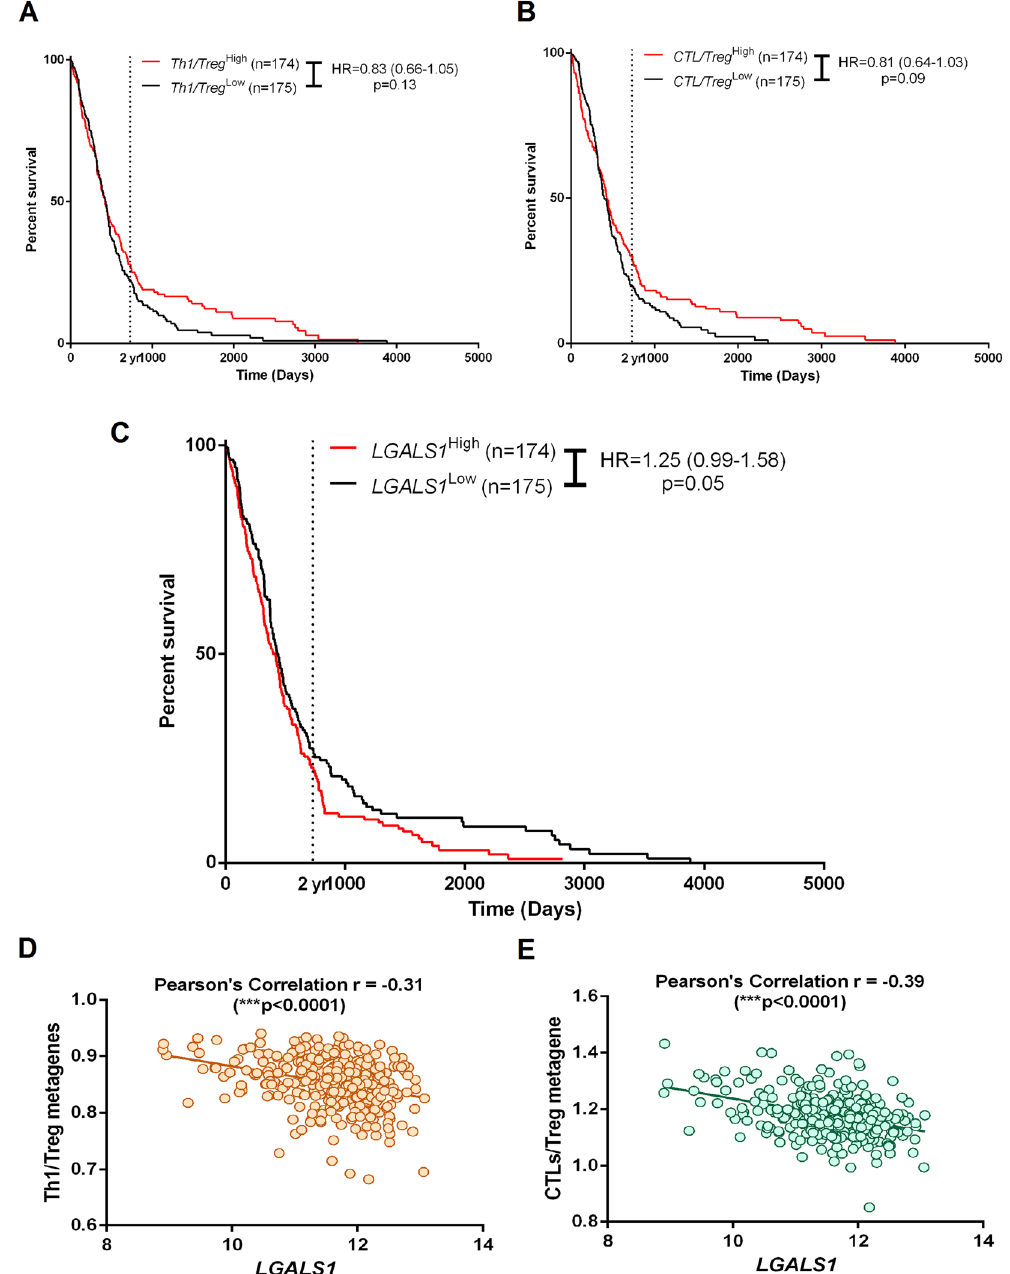
Figure 5. Analysis of association between T cell-associated genetic signatures and LGALS1 in human glioblastoma (GBM) patients. ( A ) The ratio of genetic signatures or metagenes specific for Th1 and Treg was used to stratify the The Cancer Genome Atlas (TCGA) GBM patients into “high Th1/Treg ratio” (red) or “low Th1/Treg ratio” groups; followed by Kaplan-Meier plotting of patient’s overall survival versus follow-up duration in days. ( B ) The ratio of genetic signatures or metagenes specific for CTLs and Treg was used to stratify the TCGA GBM patients into “high CTL/Treg ratio” (red) or “low CTL/Treg ratio” groups; followed by Kaplan- Meier plotting of patient’s overall survival versus follow-up duration in days. ( C ) The differential expression of LGALS1 was used to stratify the TCGA GBM patients into “high expression” (red) or “low expression” groups; followed by Kaplan-Meier plotting of patient’s overall survival versus follow-up duration in days. In A–C graphs, log-rank (Mantel-Cox) test p-values and hazard ratios (HR) with 95% confidence interval (in paranthesis) are displayed. Alternatively, a Pearson’s correlation coefficient was calculated to assess the overall association between LGALS1 expression and overall expression of either Th1/Treg ratio ( D ) or CTL/Treg ratio ( E